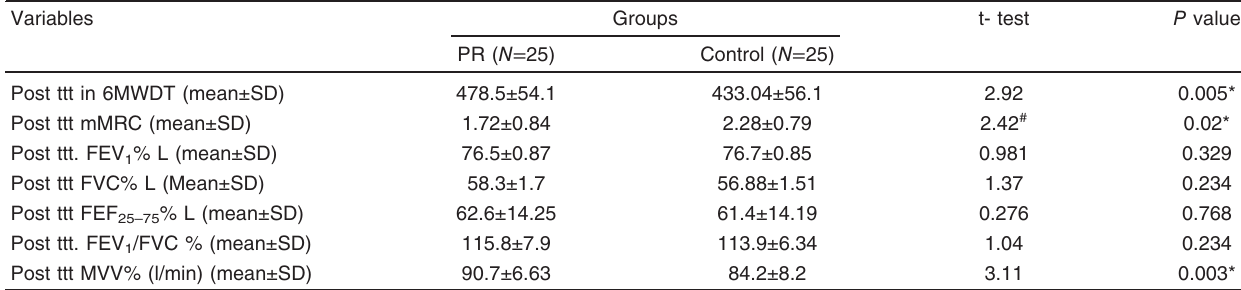
Table 4 Comparison between both studied groups as regards postpulmonary rehabilitation change in dyspnea score by modified Medical Research Council, 6min walk distance test, and change in spirometric parameters Variables